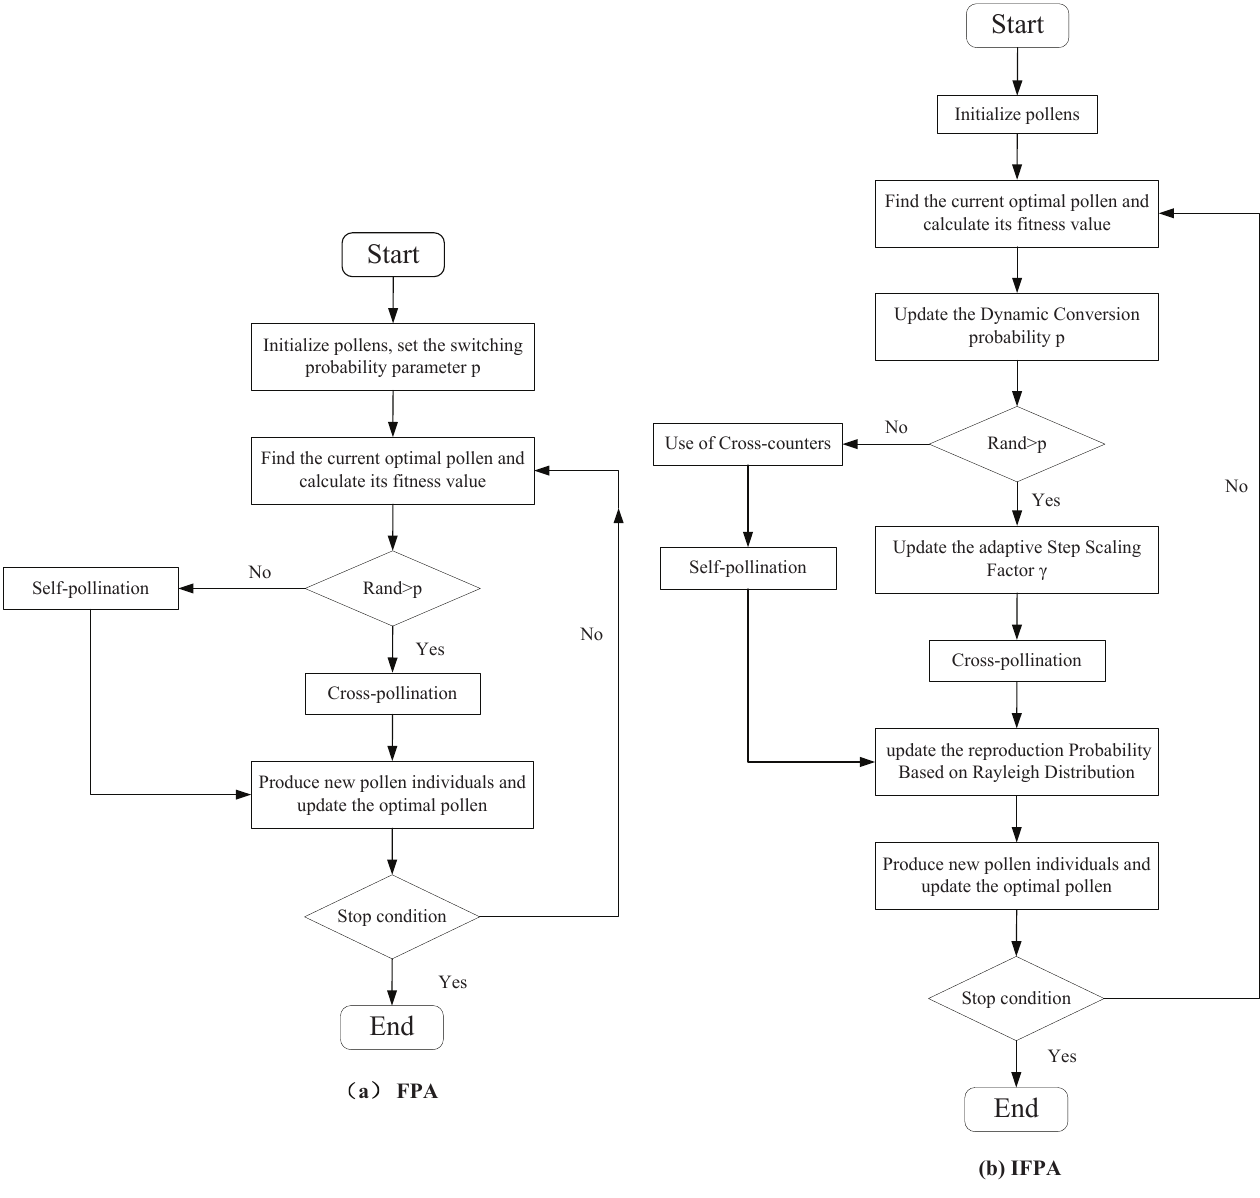
Figure 2. Flow charts of the FPA and the I-FPA. ( a ) FPA. ( b ) I-FPA. The switching probability p is dynamically adjusted according to the number of iterations. This adjusting can overcome local optimum and slow convergence. In the early stage, the dynamic switching probability p is small and the adaptive step size γ is large due to the small number t of iterations. The algorithm tends to the global search which has high search efficiency. With the increasing of t , p becomes larger and γ becomes smaller, and this makes the algorithm tend to the local search. This change lets the algorithm be able to find the optimal solution more quickly. The introduction of cross-counters p c improves the algorithm’s accuracy while simultaneously maintaining the diversity of the population. Hence, comparing with the FPA, the I-FPA has higher convergence rate and